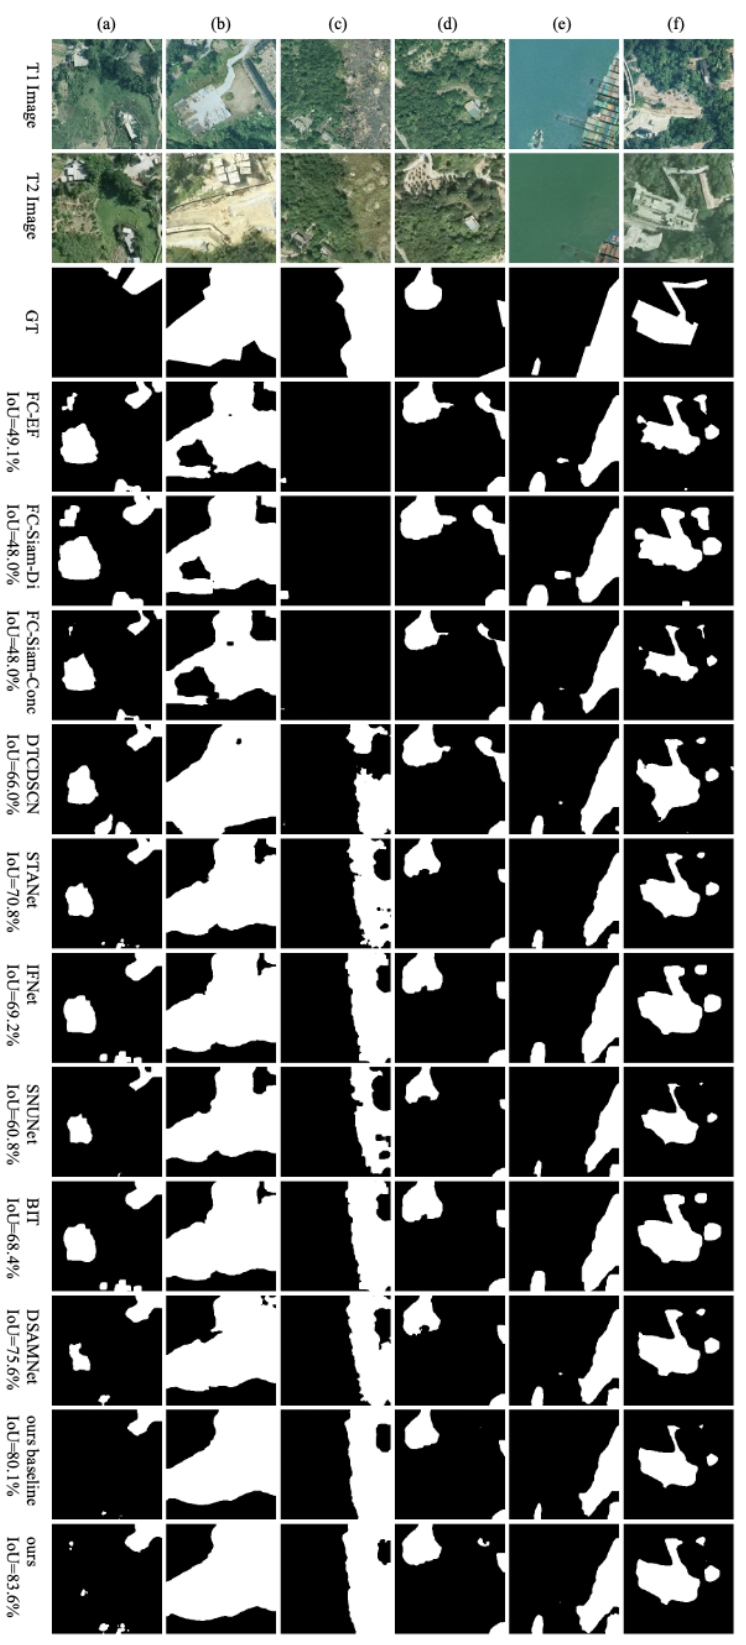
Figure 5. Visual comparison with other methods on binary change detection. We also list IoU values of each method over the sample images. Subfigures ( a – f ) are six samples from SYSU-CD